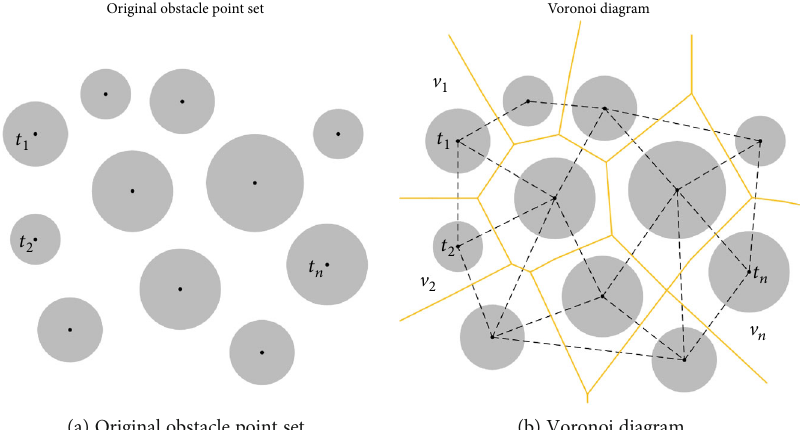
Figure 10: Process of the space clipping